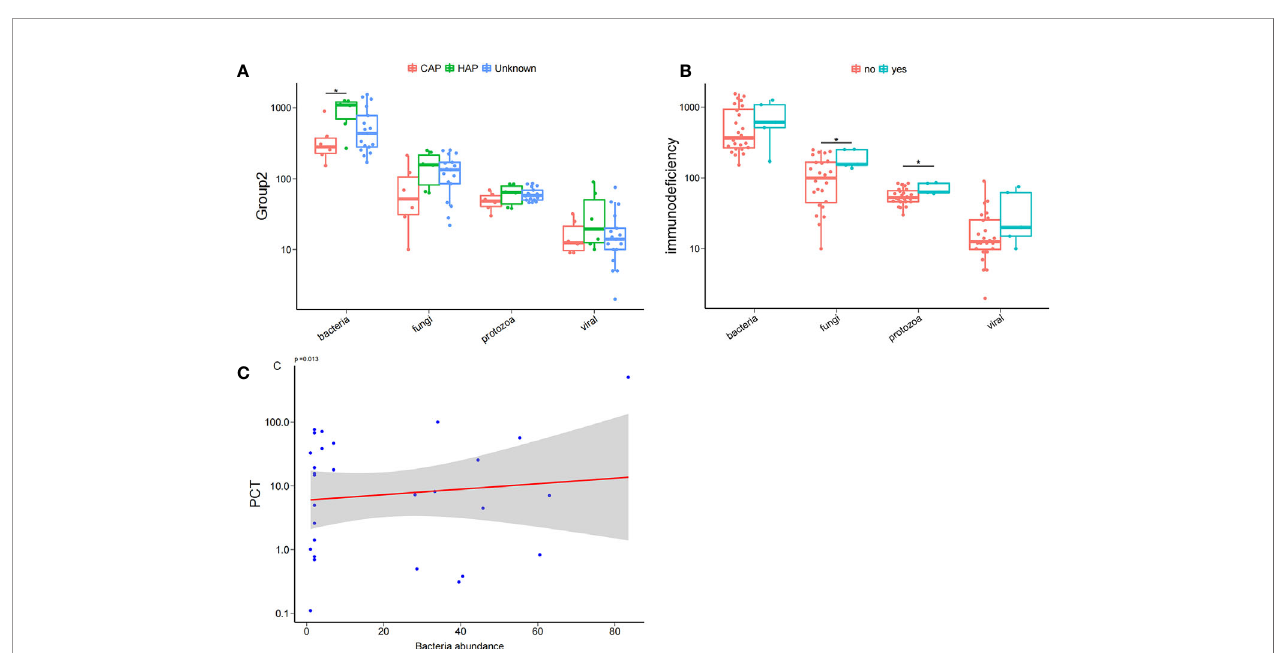
FIGURE 1 | Bloodstream microbial ecological diversity in children in PICU. (A) The number of bloodstream bacterial species in children with hospital-acquired pneumonia (HAP) was signi fi cantly higher than in those with community-acquired pneumonia (CAP), P < 0.05, Wilcoxon rank-sum test. (B) The number of bloodstream fungi and protozoa in children with immunode fi ciency disease was signi fi cantly higher compared with non-de fi cient children, P < 0.05, Wilcoxon rank- sum test; (C) PCT was positively correlated with the bacteria abundance. *P <